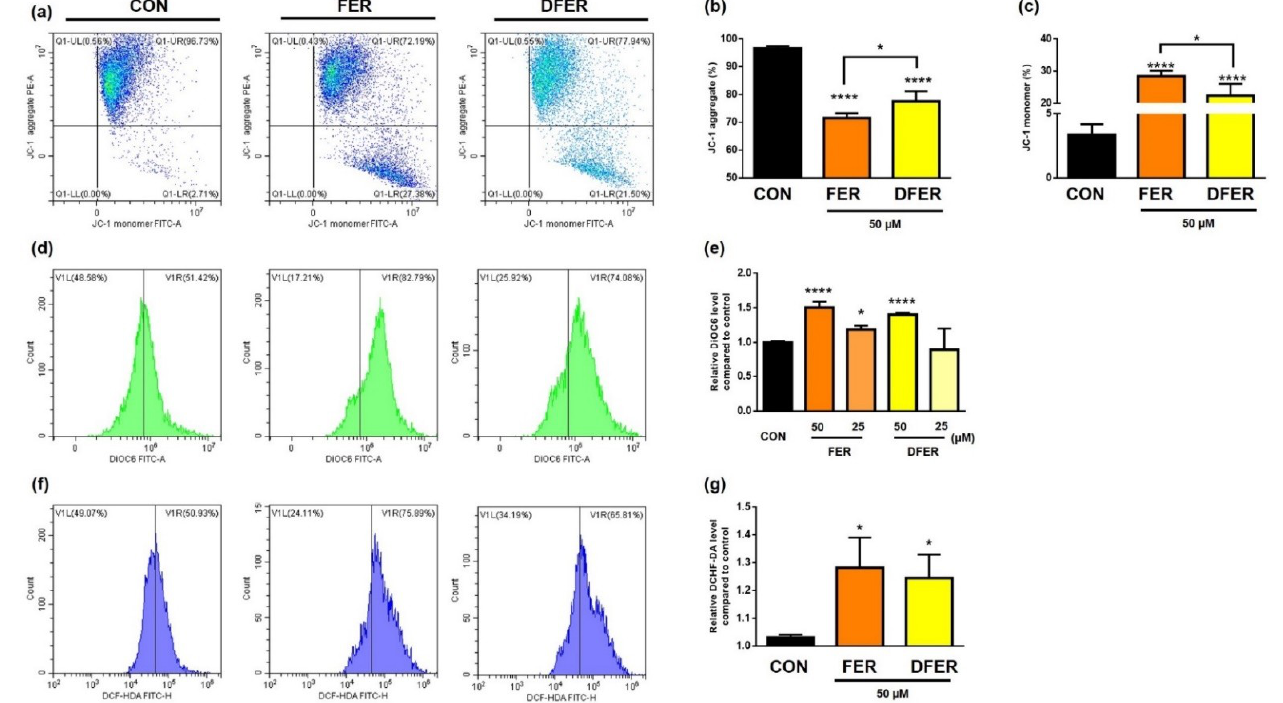
Figure 5. FER and DFER induce ROS and cause MMP abnormality in HCT116 cells. ( a ) JC-1 aggregate and monomer distribution, and relative levels of ( b ) JC-1 aggregate and ( c ) monomer in FER- or DFER-treated HCT116 cells, revealed by JC-1 staining. ( d ) Fluorescence intensity of DiOC6 staining and ( e ) relative level of the intensity in FER- or DFER-treated HCT116 cells by DiOC6 staining. ( f ) The ROS level analyzed by using DCFH-DA staining, and ( g ) relative level. Symbols (*) and (****) indicate significant differences ( p < 0.05) and ( p < 0.001), respectively, analyzed using Student’s t -test, as compared to the control group.